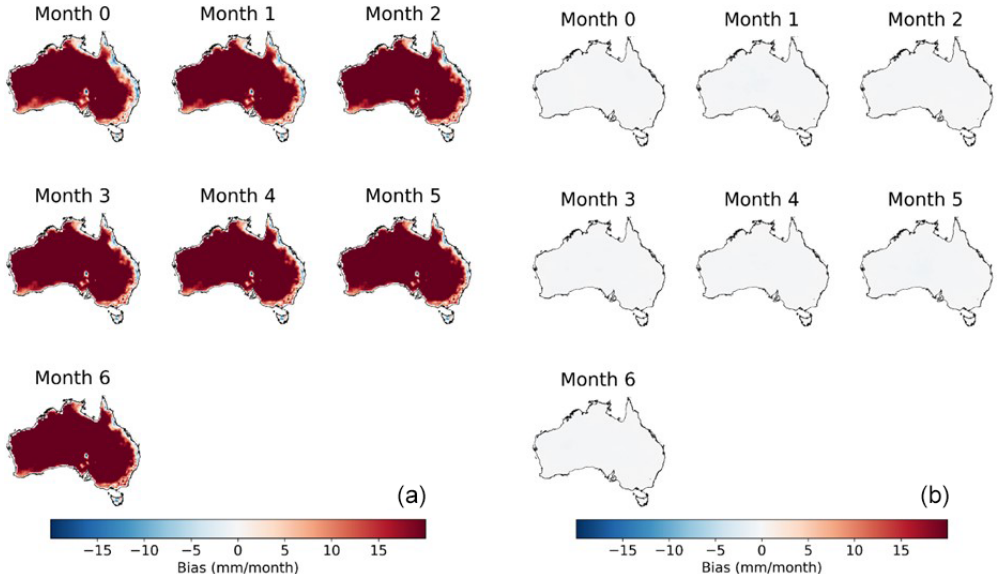
Figure 7. Bias in (a) raw and (b) BJP-ti calibrated ET o forecasts.